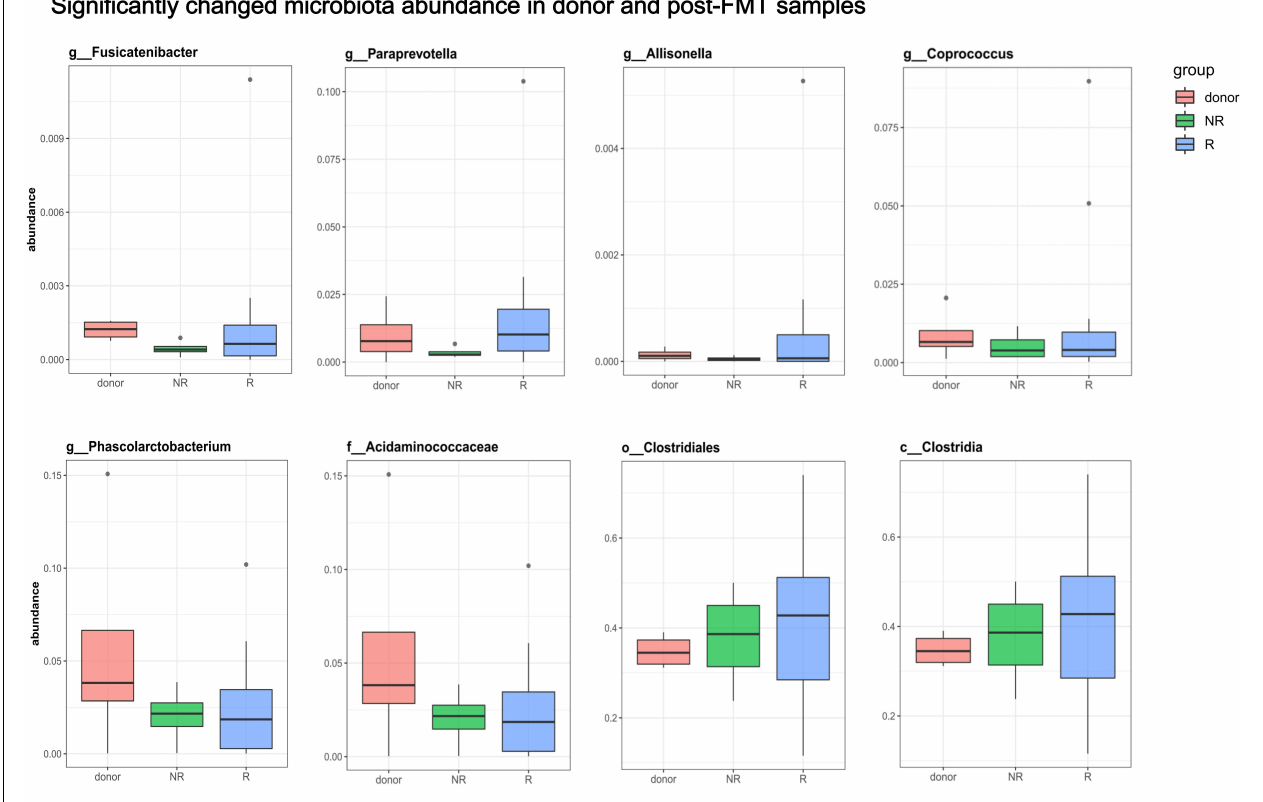
FIGURE 4 | Comparisons of the significantly altered bacterial abundances among donors and post-FMT fecal samples. The compared bacteria were shown to be significantly enriched in post-FMT samples determined by LEFse analysis and meanwhile correlated to clinical symptoms. All 4 donors and 18 patients were included. Group R refers to post-FMT samples from patients who were clinically cured after FMT; Group NR refers to post-FMT samples from patients who were not cured by FMT. Wilcoxon tests showed no significant differences among the groups, but the abundances of Fusicatenibacter and Paraprevotella were lower in the NR group and higher in the donor and R